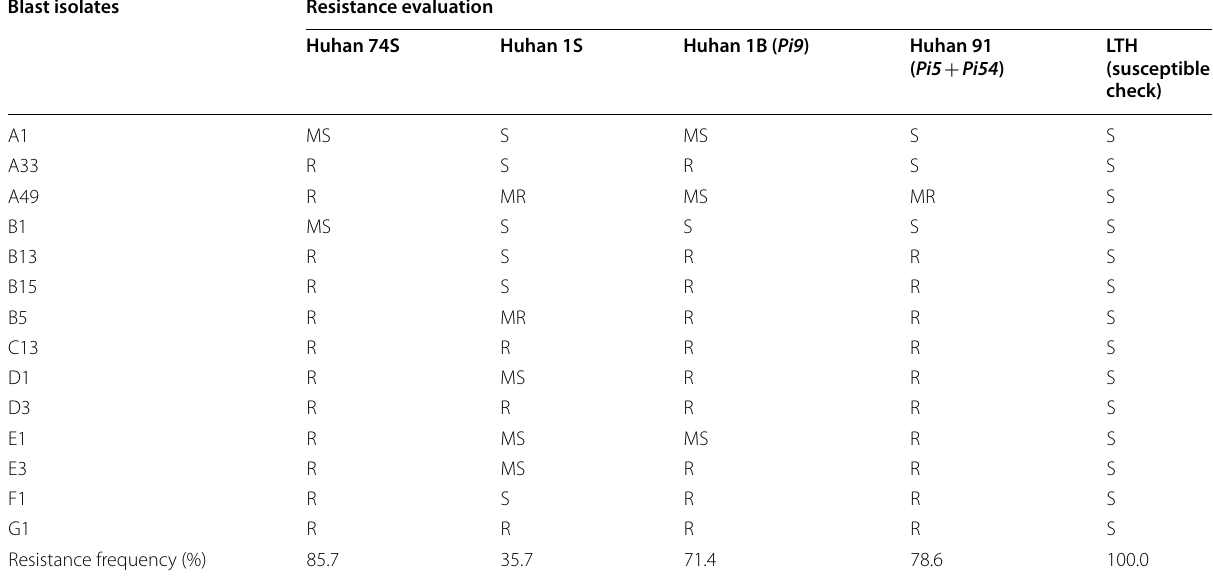
R, Resistant; MR, Medium Resistant; S, Susceptible; MS, Medium Susceptible